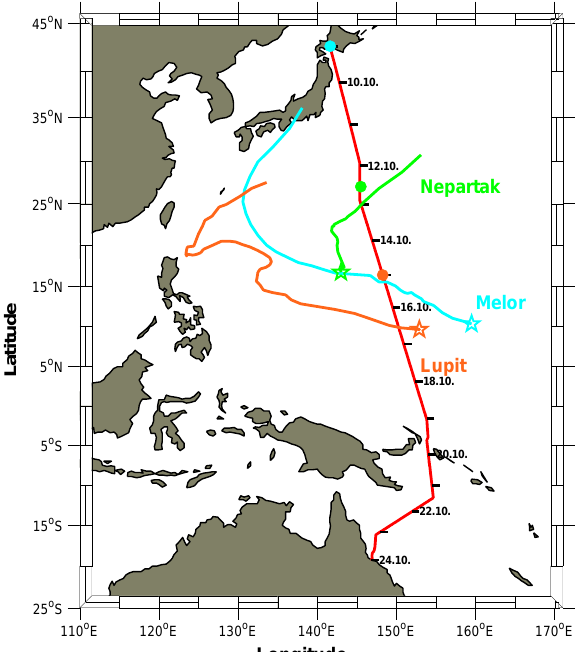
Fig. 1. TransBrom Sonne ship route in the West Pacific from 9 to 24 October 2009 (UTC time). The tracks from the tropical depression Nepartak and two typhoons Melor and Lupit are shown together with their localized influence on the ship measurements (filled cir- cles). The data are taken from the Joint Typhoon Warning Centre archive